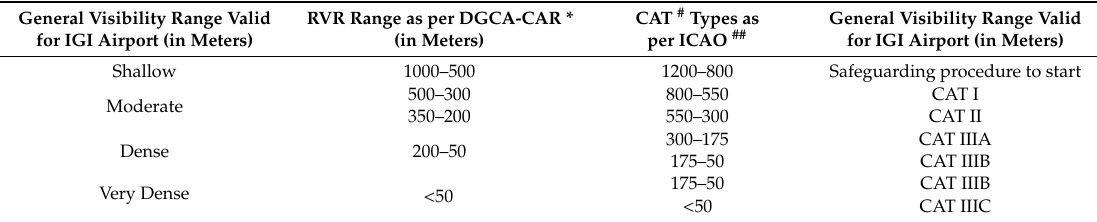
Figure 1. ( a ) Airport areas of the Indira Gandhi International (IGI) Airport and runway (RWY) orientation. All three RWYs have been in operation at IGI Airport since August 2008. ( b ) Illustration of Category – Instrument Landing Systems (CAT-ILS) Operation. Table 1. Fog types, general visibility range, and runway visibility range (RVR) for di ff erent conditions valid for Indira Gandhi International (IGI)